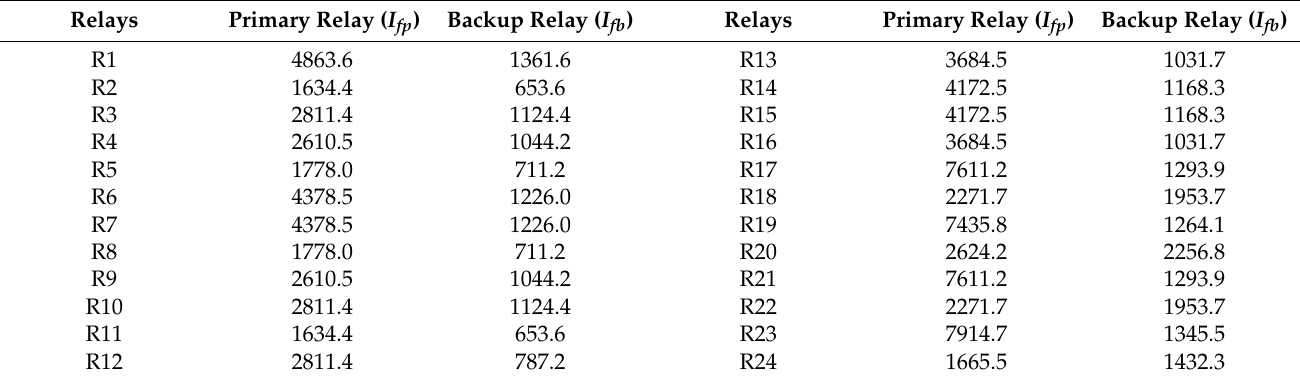
Table 2. Primary and backup relays fault currents of IEEE 9-bus system.